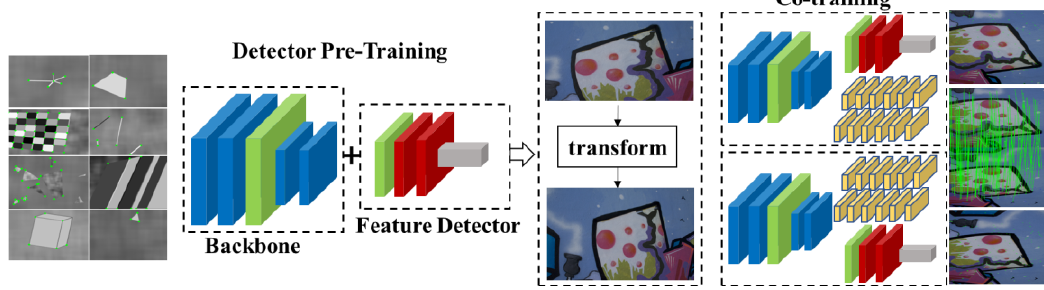
Figure 1. The frame of self-supervised training.